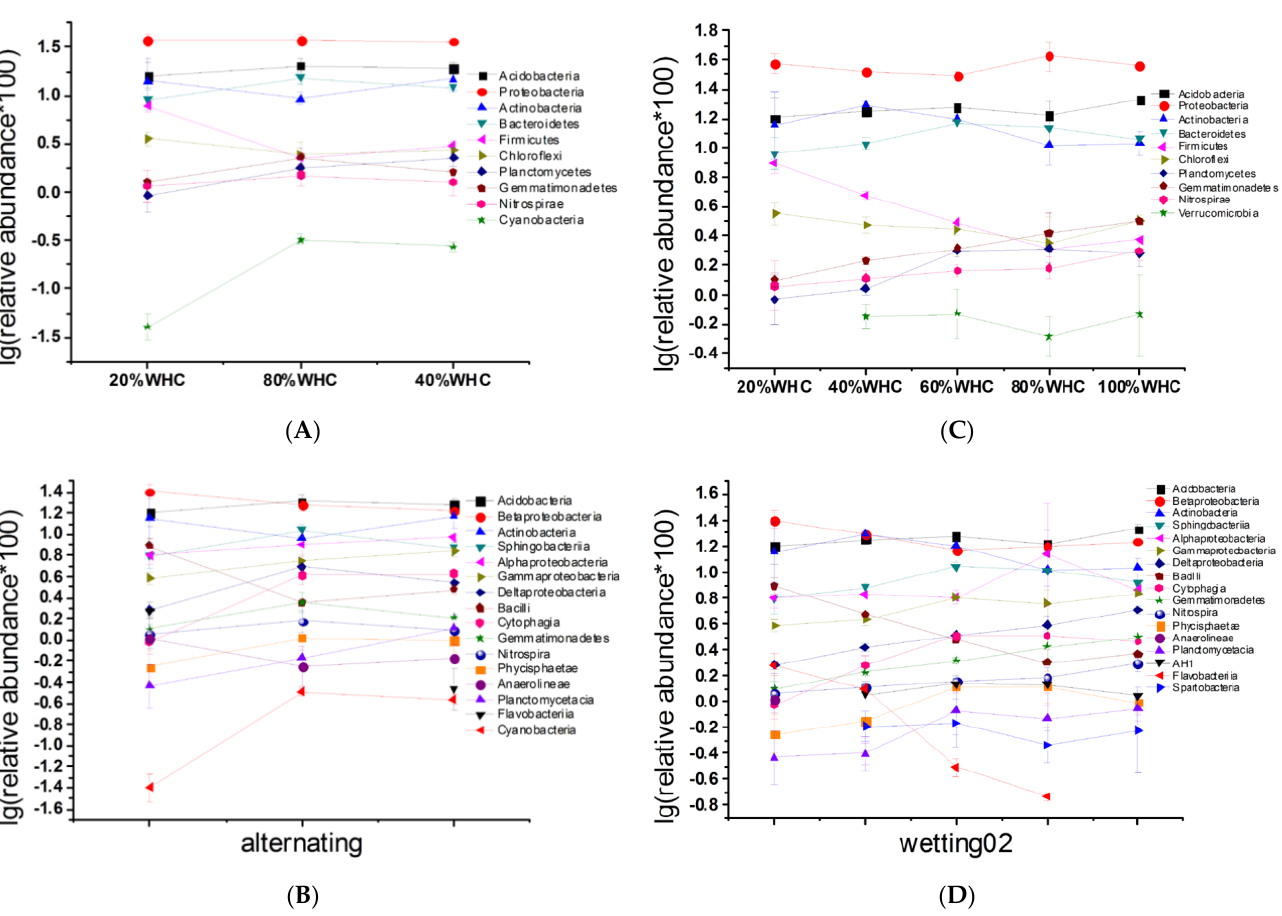
Figure 4. ( A ) Dynamics of the 16S rRNA gene-based relative abundance of the main present bacterial phyla, sequenced during wet-up and dry-down (alternating regime). ( B ) Dynamics of the 16S rRNA gene-based relative abundance of the main present bacterial classes, sequenced during wet-up and dry-down (alternating regime). ( C ) Dynamics of the 16S rRNA gene-based relative abundance of the main present bacterial phyla, sequenced during wet-up (wetting02 regime). ( D ) Dynamics of the 16S rRNA -based relative abundance of the main present bacterial classes, sequenced during wet-up (wetting02 regime). Bars indicate ± 1